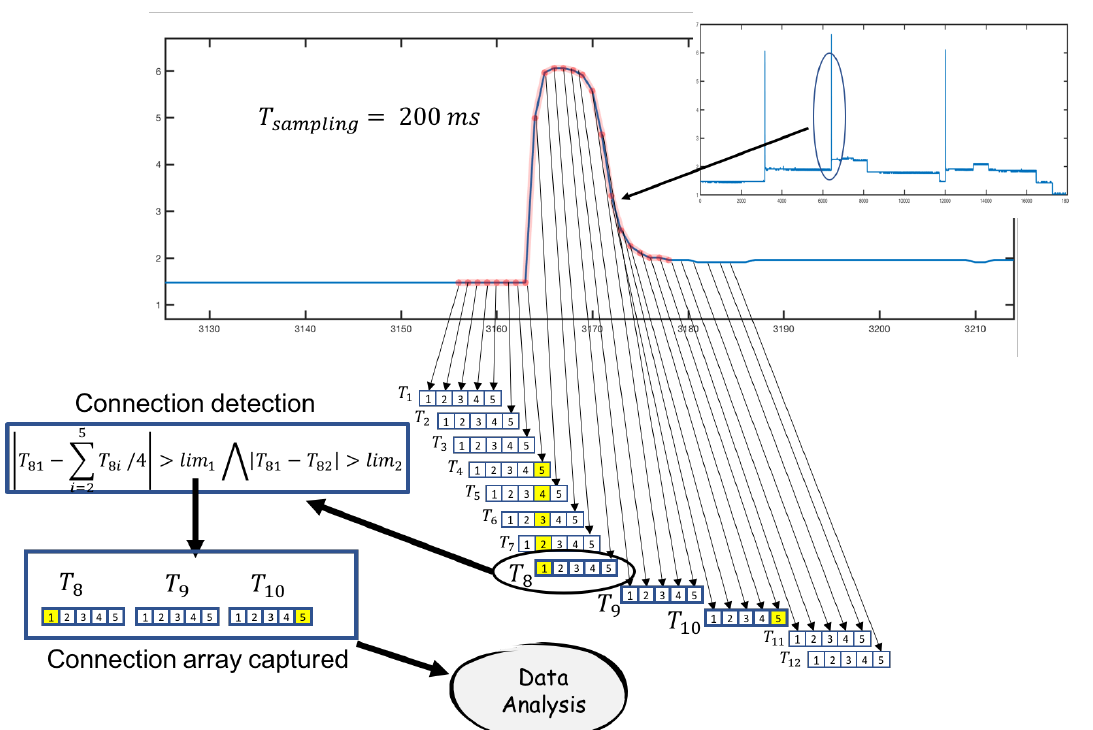
Figure 12. Load connection detection example. In the T 8 subarray, a connection is